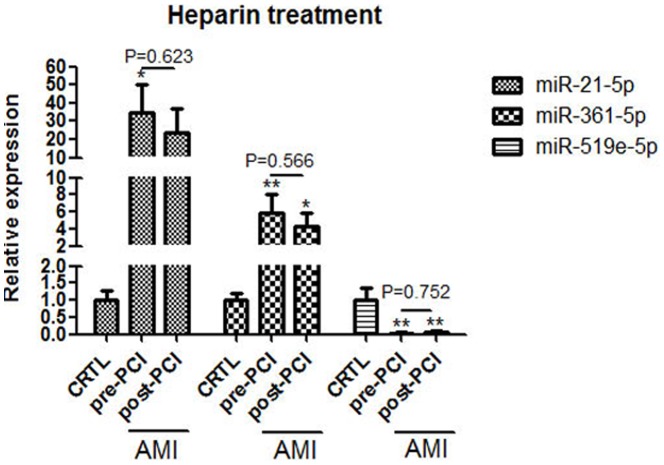
The impact of heparin on circulating miRNAs' expressions.CRTL, control; Data are presented as mean ± SEM, *p<0.05, **p<0.01 versus control.